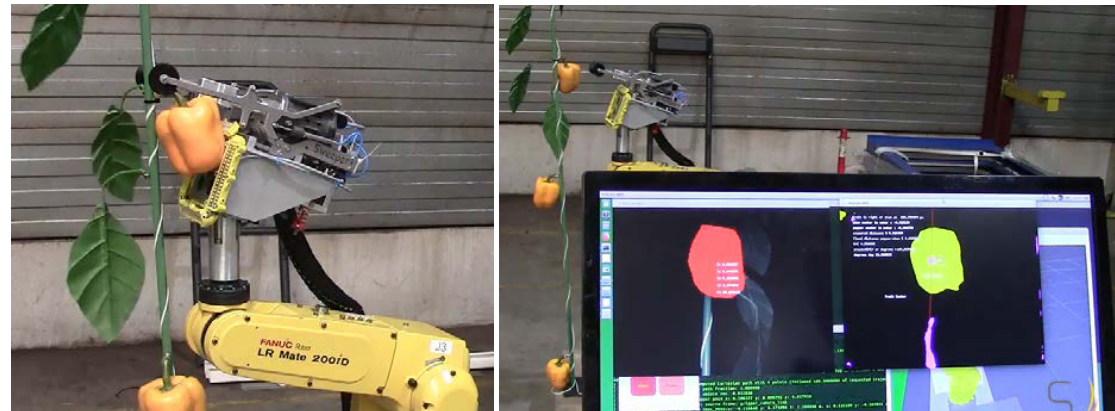
Figure 4. Detection of an artificial plant model via color-based detection after threshold re-calibration. Image courtesy Bogaerts Greenhouse Logistics. The robotic harvesting system successfully detects and “harvests” an artificial pepper fruit ( left ) while the detection algorithm’s results are displayed to the operator on a graphical user inteface ( left